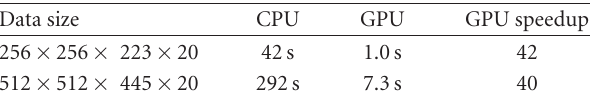
Table 4: Processing times for lowpass filtering the 10 tensor components, calculating γ and mapping the structure tensor to the control tensor for the di ff erent implementations. The processing times for the GPU do not include the time it takes to transfer the data to and from the